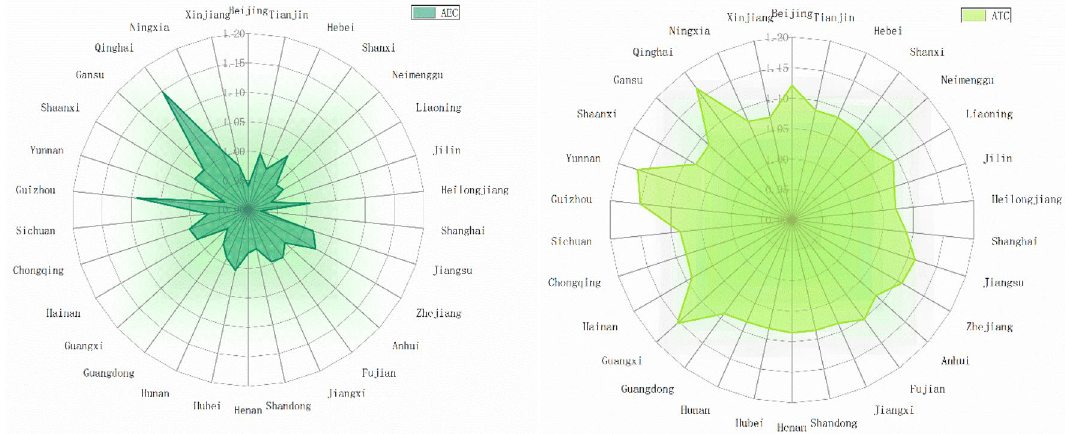
Figure 3. Spatial heterogeneity of AEC and ATC in 30